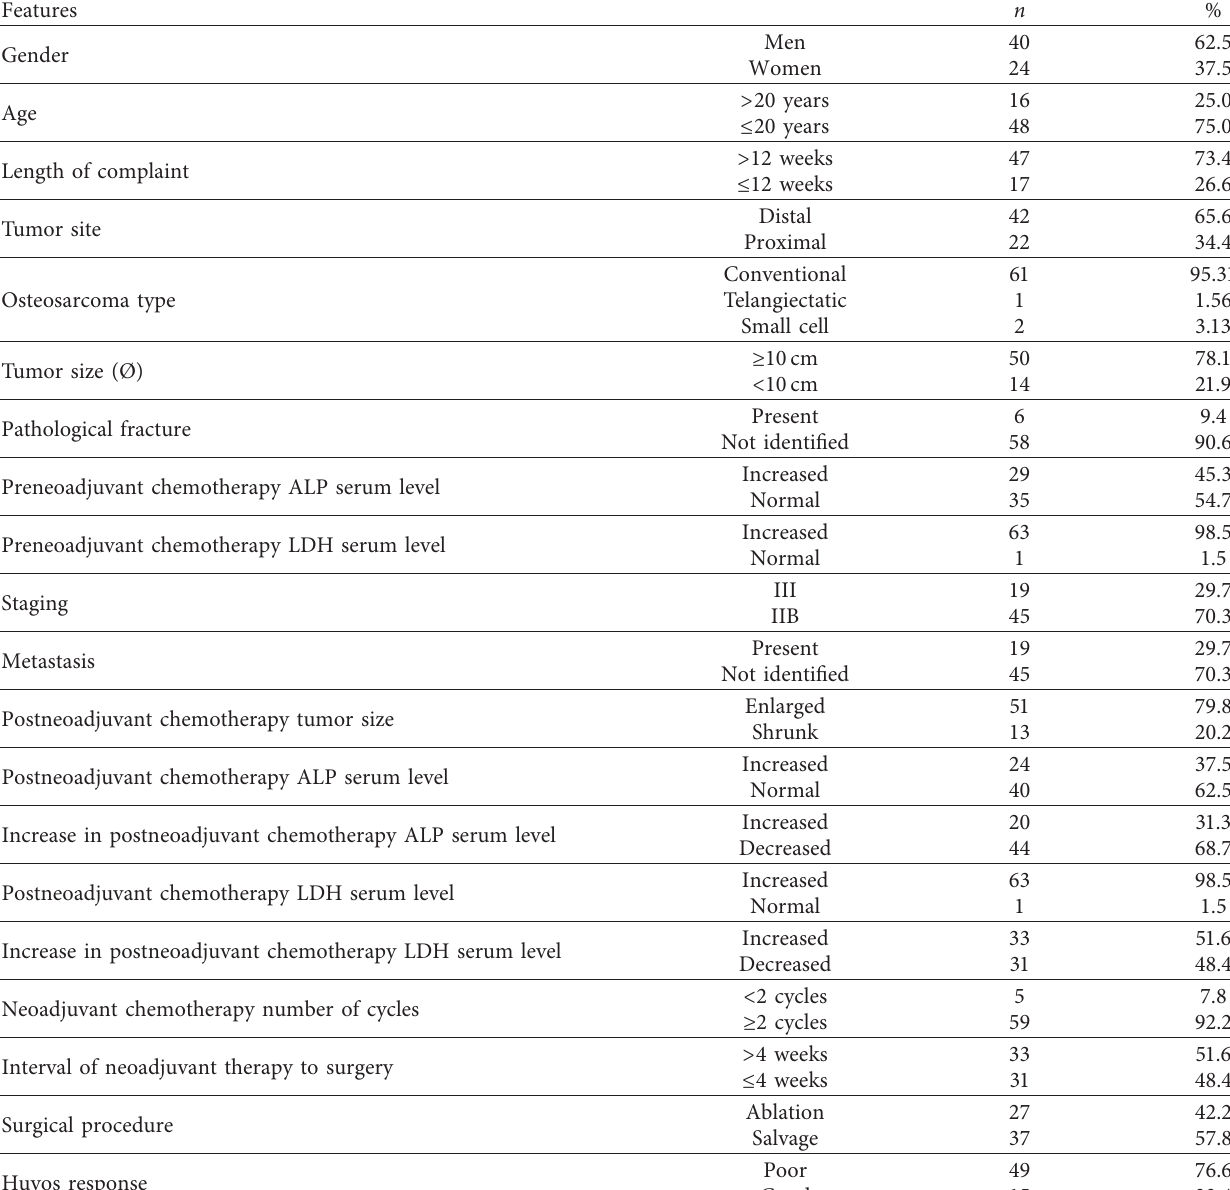
Table 1: Patient demographics and